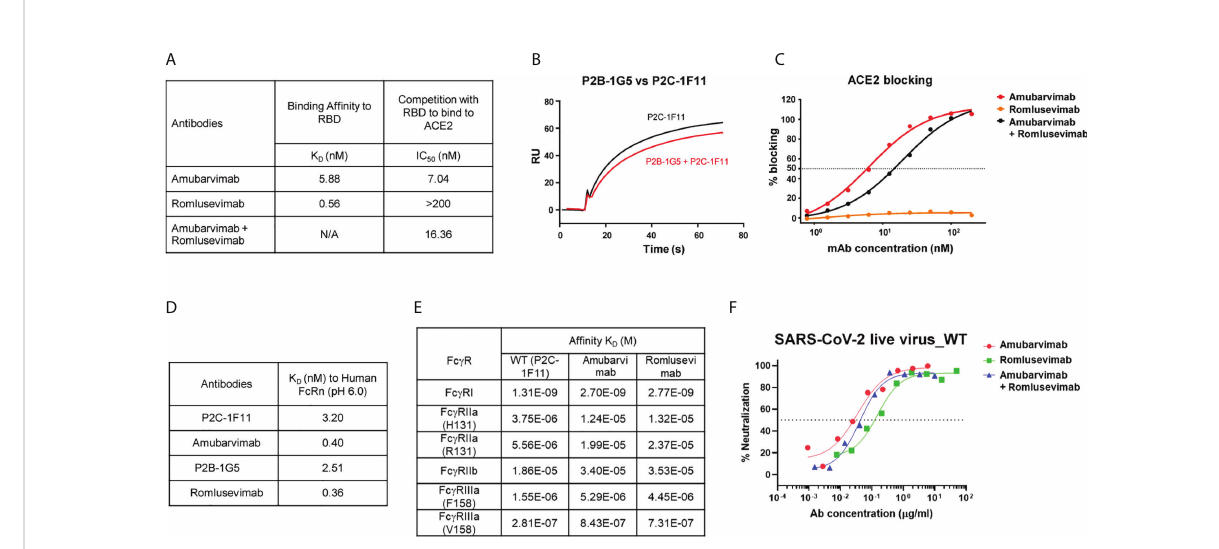
FIGURE 1 Amubarvimab and romlusevimab non-competitively bind to RBD with modi fi ed Fc. (A) Amubarvimab and romlusevimab binding af fi nity measured by SPR to RBD and degree of competition with RBD to bind to ACE2. (B) Competition of P2B-1G5 and P2C-1F11, the precursors of amubarvimab and romlusevimab, for binding to RBD measured by SPR. Blocking ef fi ciency was determined by comparison of response units (RU) with and without prior antibody incubation. (C) Competition of amubarvimab and romlusevimab together with ACE2 for binding to SARS- CoV-2 RBD. Measurements were taken across a series of mAb concentrations and the resulting nonlinear regression curves were used to calculate IC 50 values. (D) Binding af fi nity of amubarvimab, romlusevimab and their precursors P2C-1F11 and P2B-1G5 to human FcRn at pH 6.0 measured by SPR. (E) Binding af fi nity of amubarvimab and romlusevimab to human Fc g Rs measured by SPR. (F) Neutralization potency of